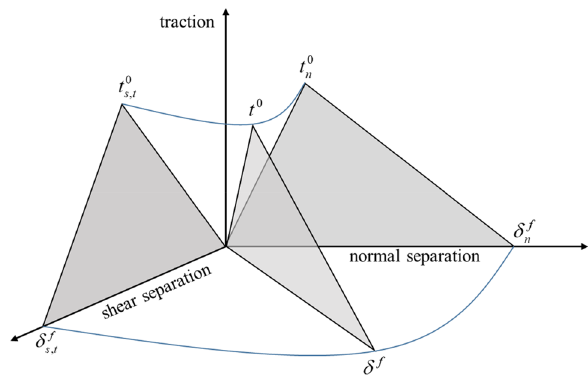
Fig. 4 A typically bilinear traction–separation